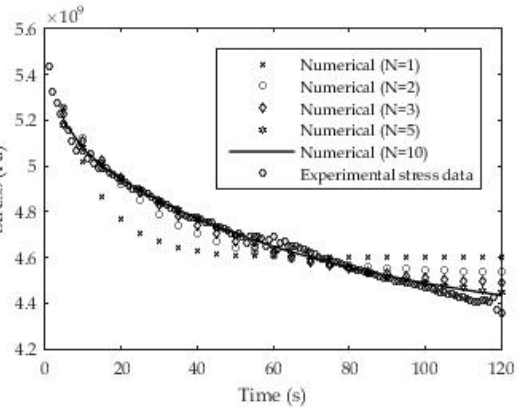
Figure 16. Numerical results for the relaxation test depending on the number members in the Prony series.